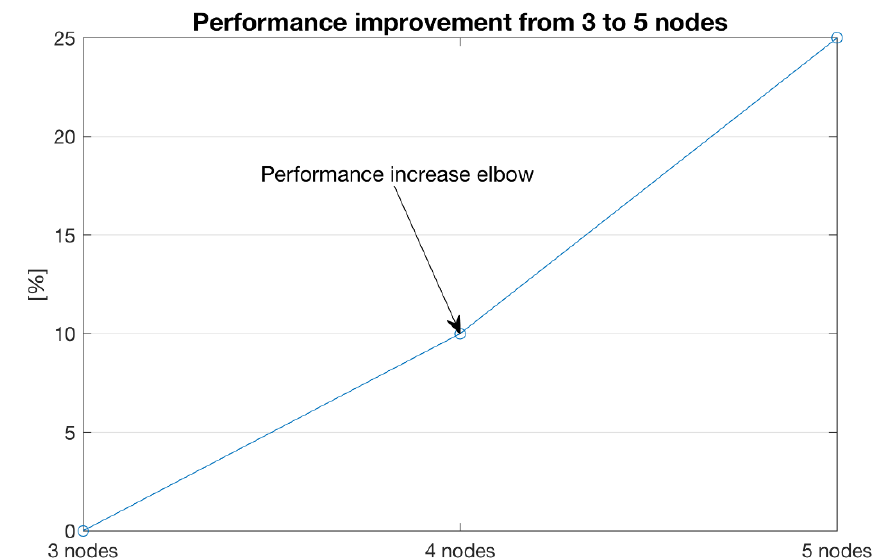
Figure 11. Performance improvement comparing three to five nodes in the Vertica cluster for 1 TB database size.